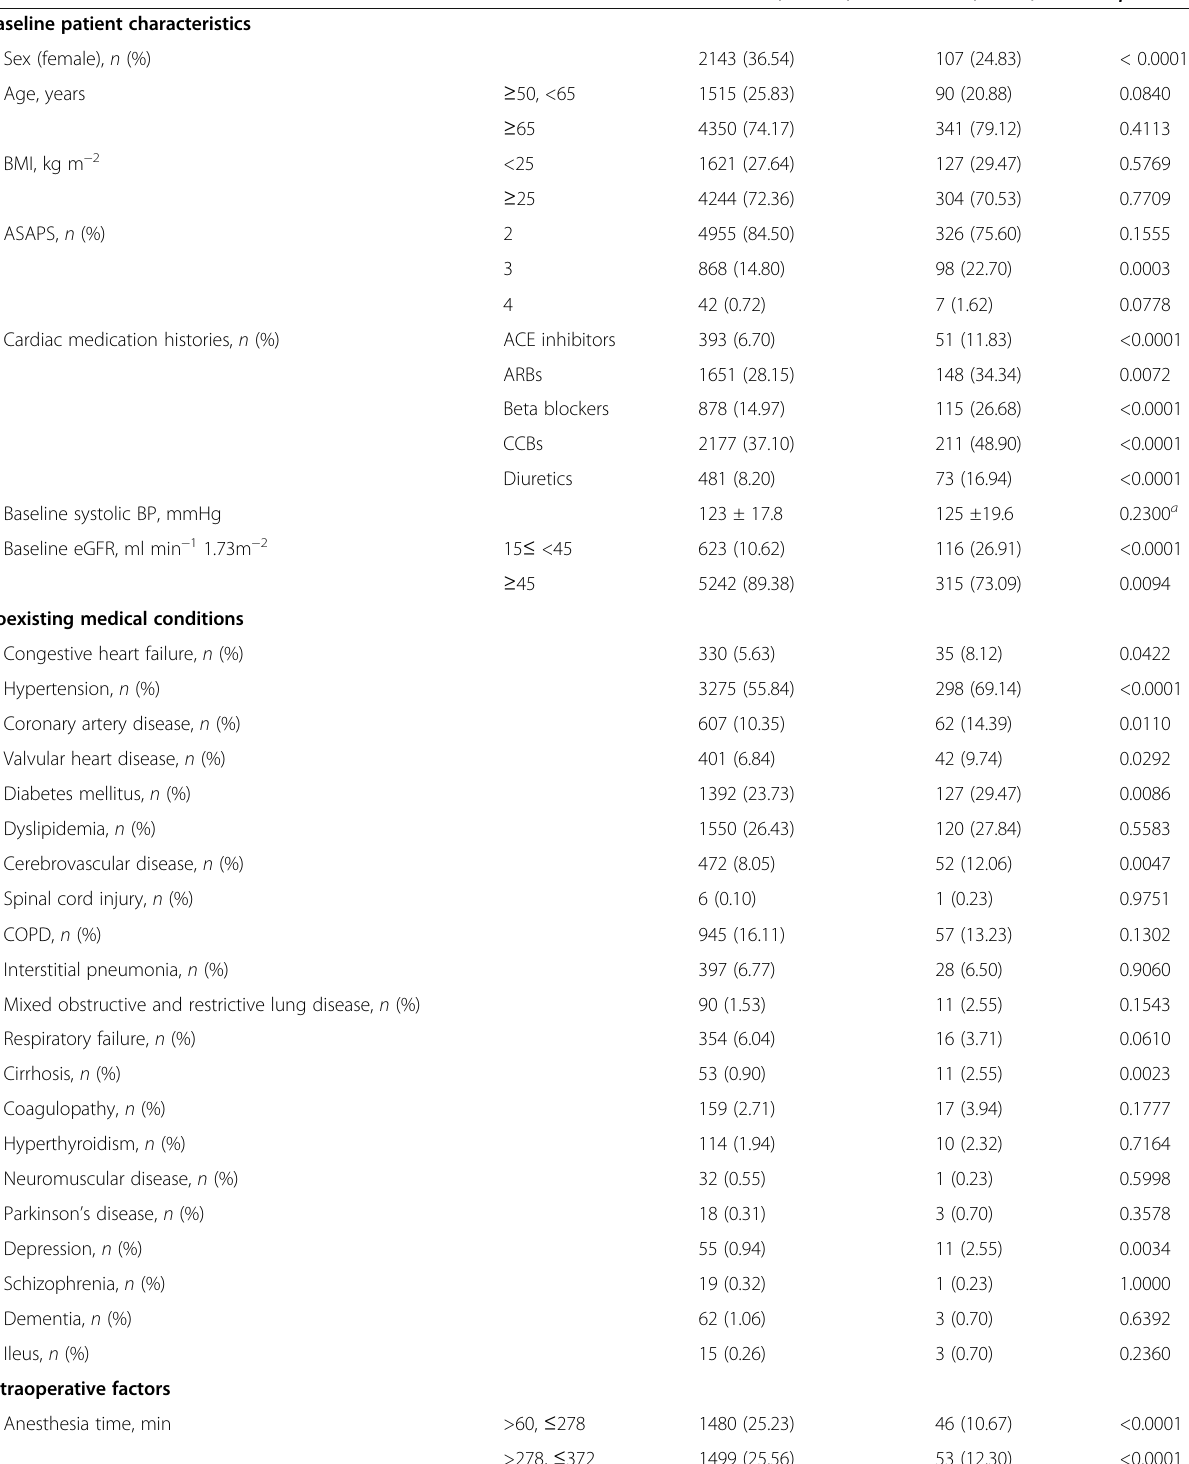
Table 1 Patients ’ baseline characteristics, coexisting medical conditions, intraoperative characteristics, and surgical procedures by acute kidney injury ( N